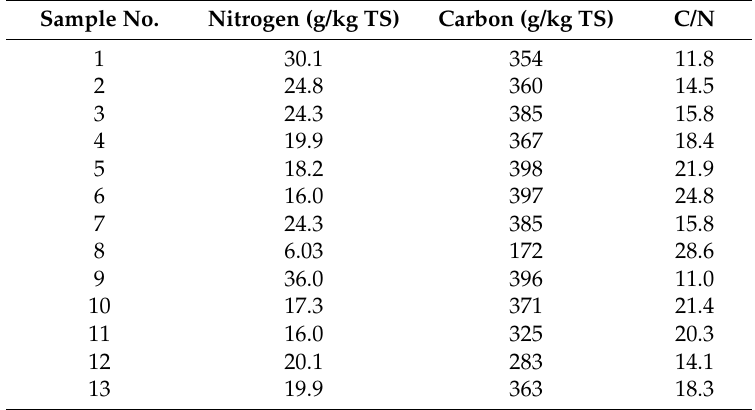
Table 4. Carbon and nitrogen contents in plant material in samples from standing bodies of water (Samples 8–10 are from summer harvesting).